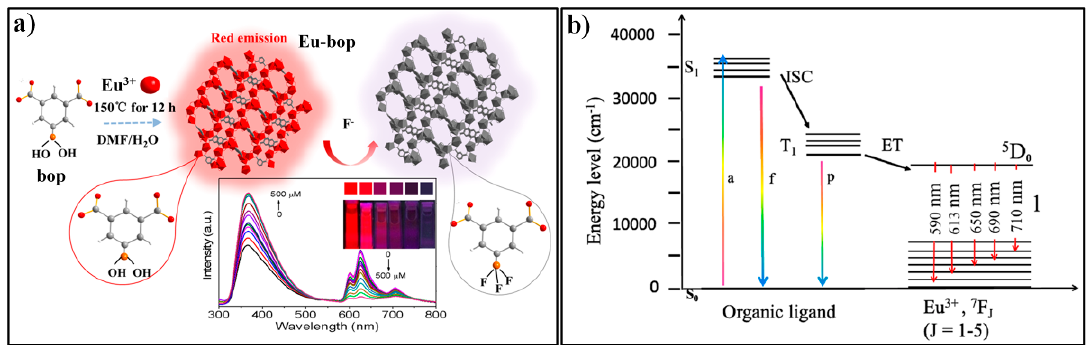
Figure 19. ( a ) The synthesis of Eu-bop and its sensing process for F − . ( b ) Schematic representation of absorption, migration, and emission of Eu-bop. Reproduced with permission from [141]. Copyright American Chemical Society, 2017.